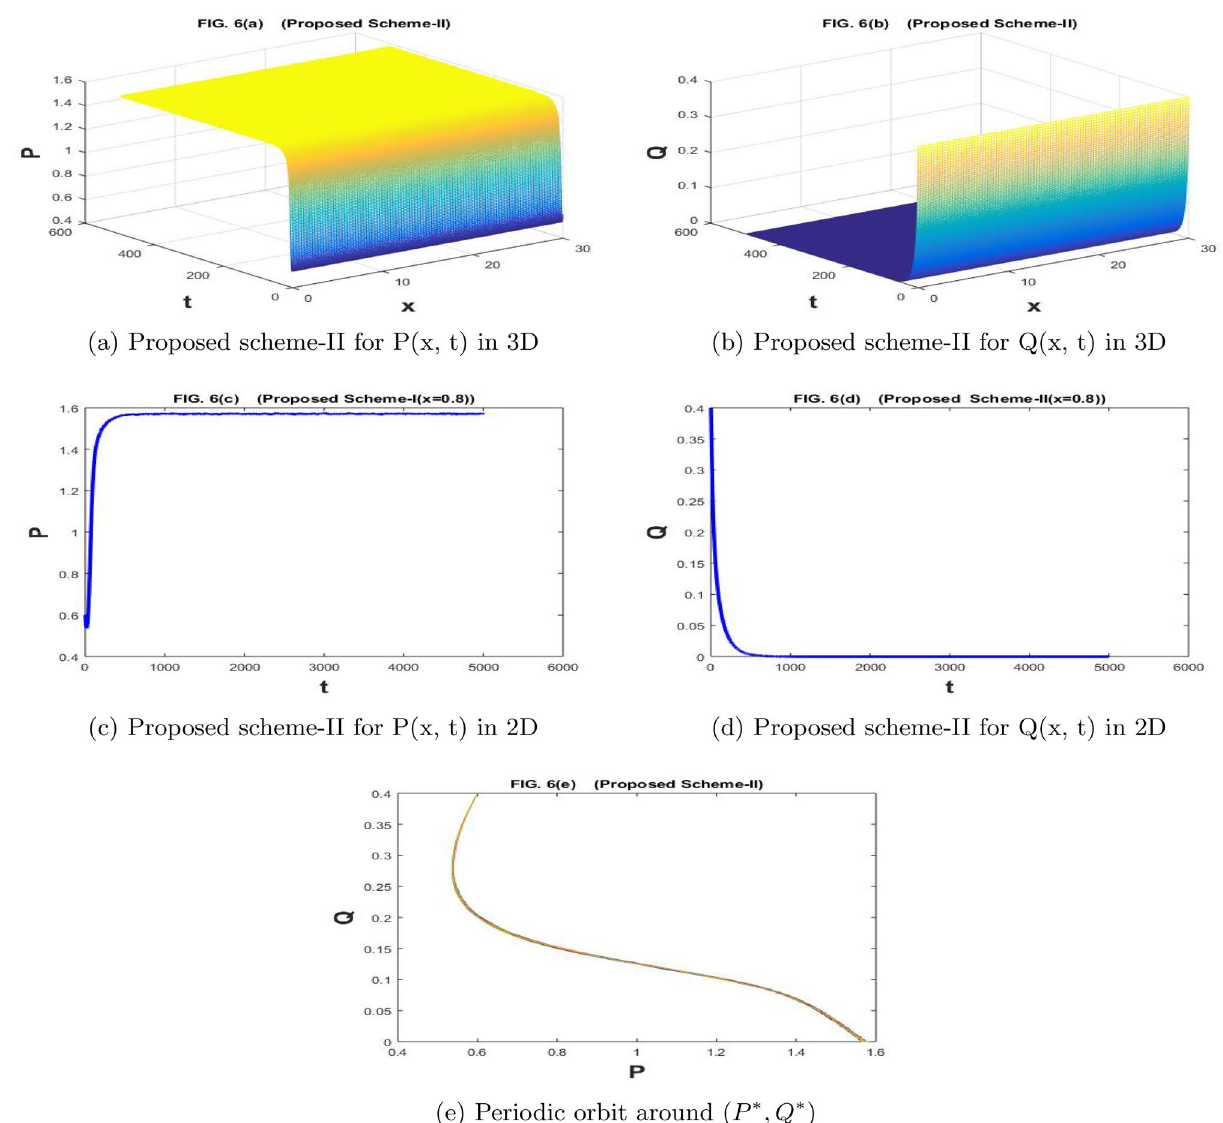
Figure 6. The subfig ( a and c ) and ( b and d ) represents the numerical approximation of P ( x , t ), and Q ( x , t ) respectively by proposed scheme-II. The subfig ( e ) represents the periodic orbit around ( P ∗ , Q ∗ )